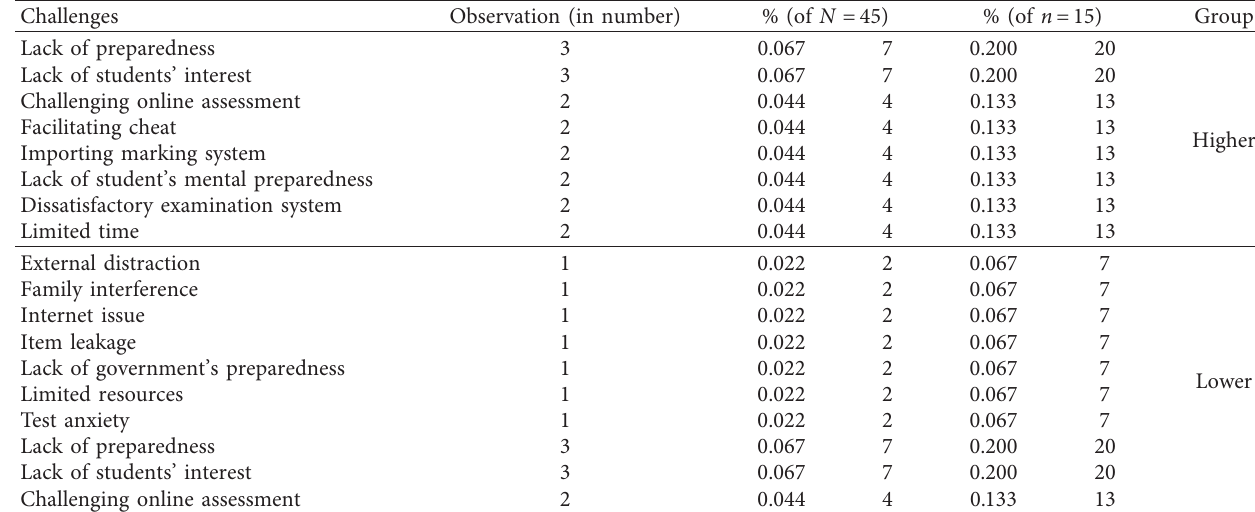
Table 15: Percentage of each challenge of assessment in online learning and their groups based on 50th quartile.